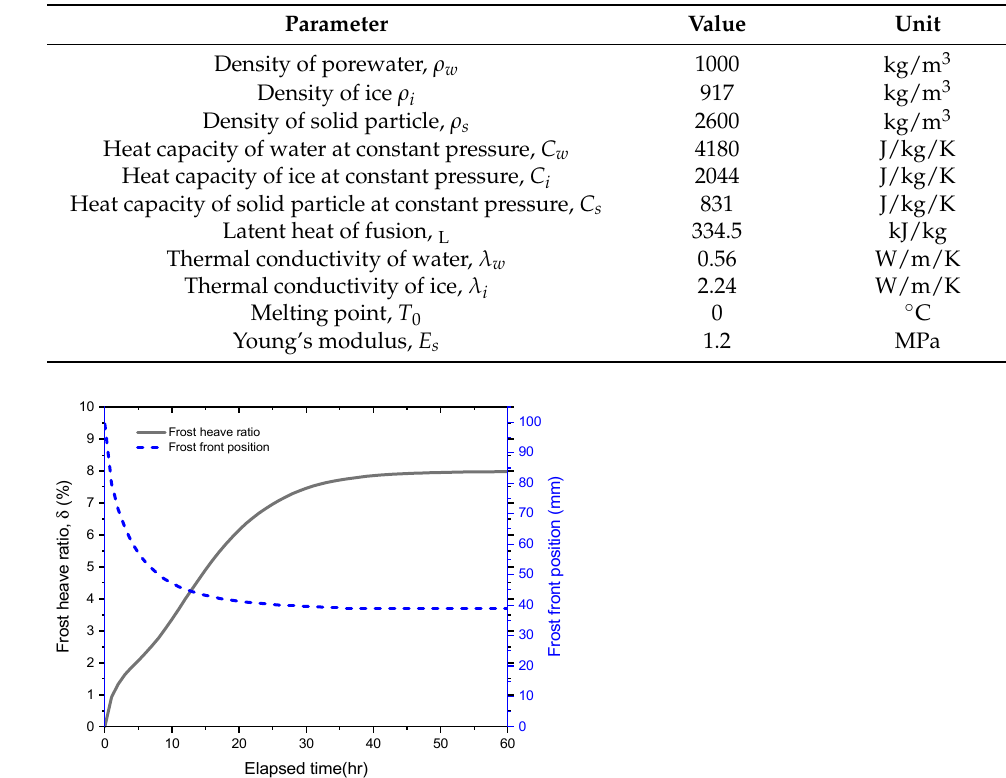
Table 1. Material properties used in FE model.